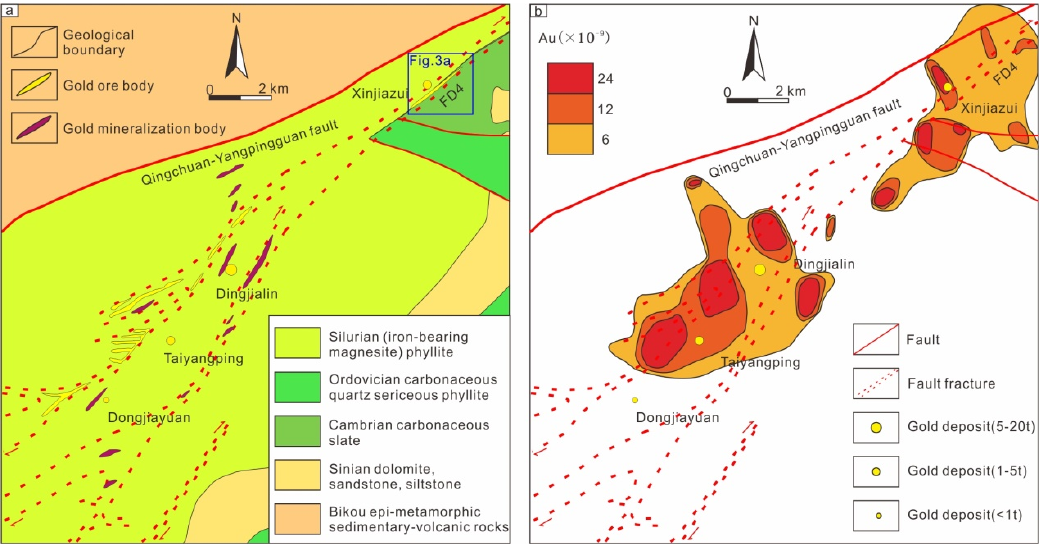
Figure 2. Regional geological map ( a ) and gold anomalies from stream sediment geochemistry ( b ) of the Xinjiazui–Dingjialin–Dongjiayuan gold metallogenic belt (modified from 1: 200,000 Bikou geological map; Fu et al., 2014 [40]).